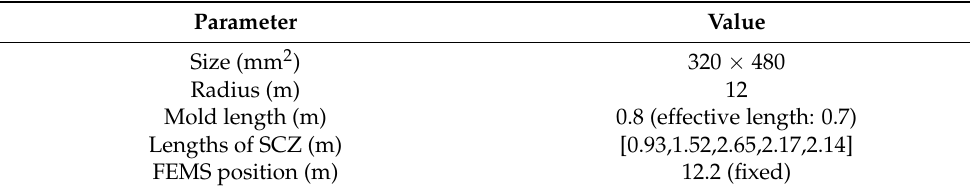
Table 5. Geometric parameters of studied caster.